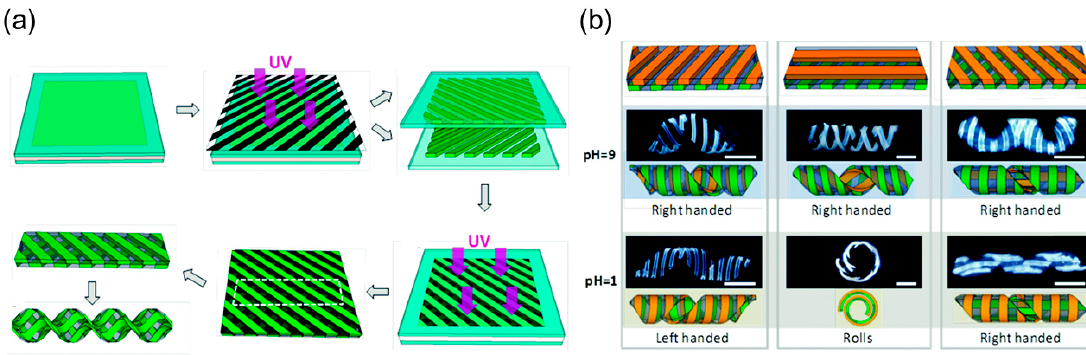
Figure 5. pH-responsive hydrogel-based helical structures mimicking Bauhinia variegata . ( a ) Schematic illustration of the three-step photo-crosslinking of PAA/PNIPAm hybrid composite guided by a photomask. The green strips are PAA while the grey part is PNIPAm. The photomask is made by drawing black lines; ( b ) Shape transformation of P(VI- co -AAM)-PNIPAm-PAA hybrid hydrogel when pH changes from 9 to 1. The brown, grey and green parts are P(VI- co -AAM), PNIPAm and PAA, respectively. The upper array shows the strip orientations in the top and bottom layers. The schematic (bottom) and experimental (top) figures of shape transformation are both shown together in the middle and bottom array. The scale bar is 1 cm ( a , b ) are from [30], reprinted with permission from The Royal Society of Chemistry.